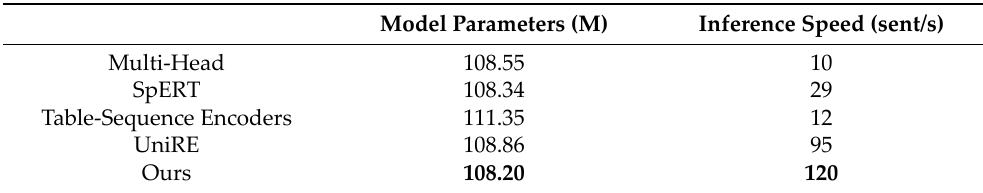
Table 6. Model parameters and inference speed comparison.